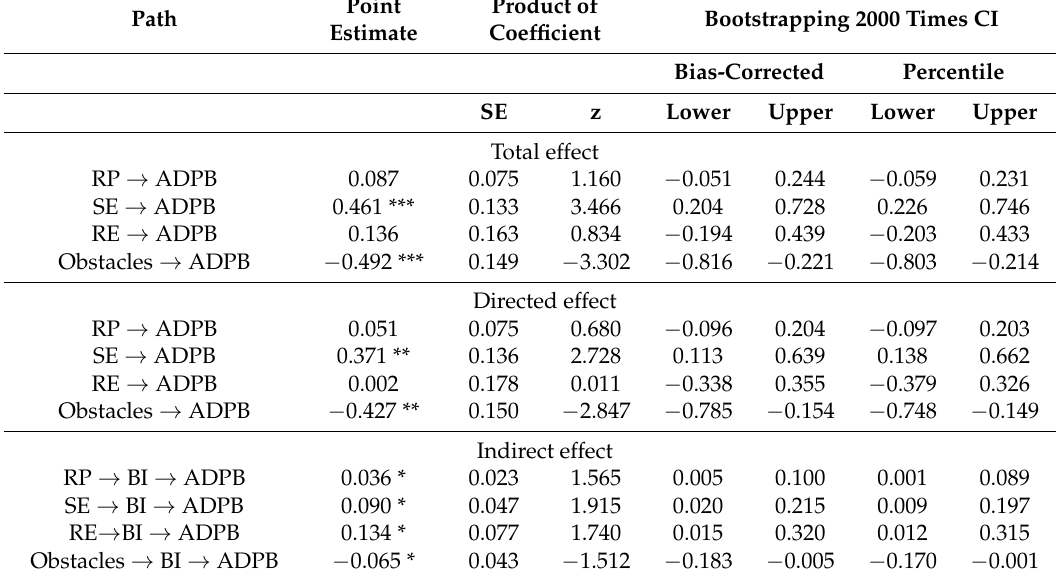
Table 3. Unstandardized, direct, and indirect effects of the hypothesized model. Point Product of Path Estimate Coefficient